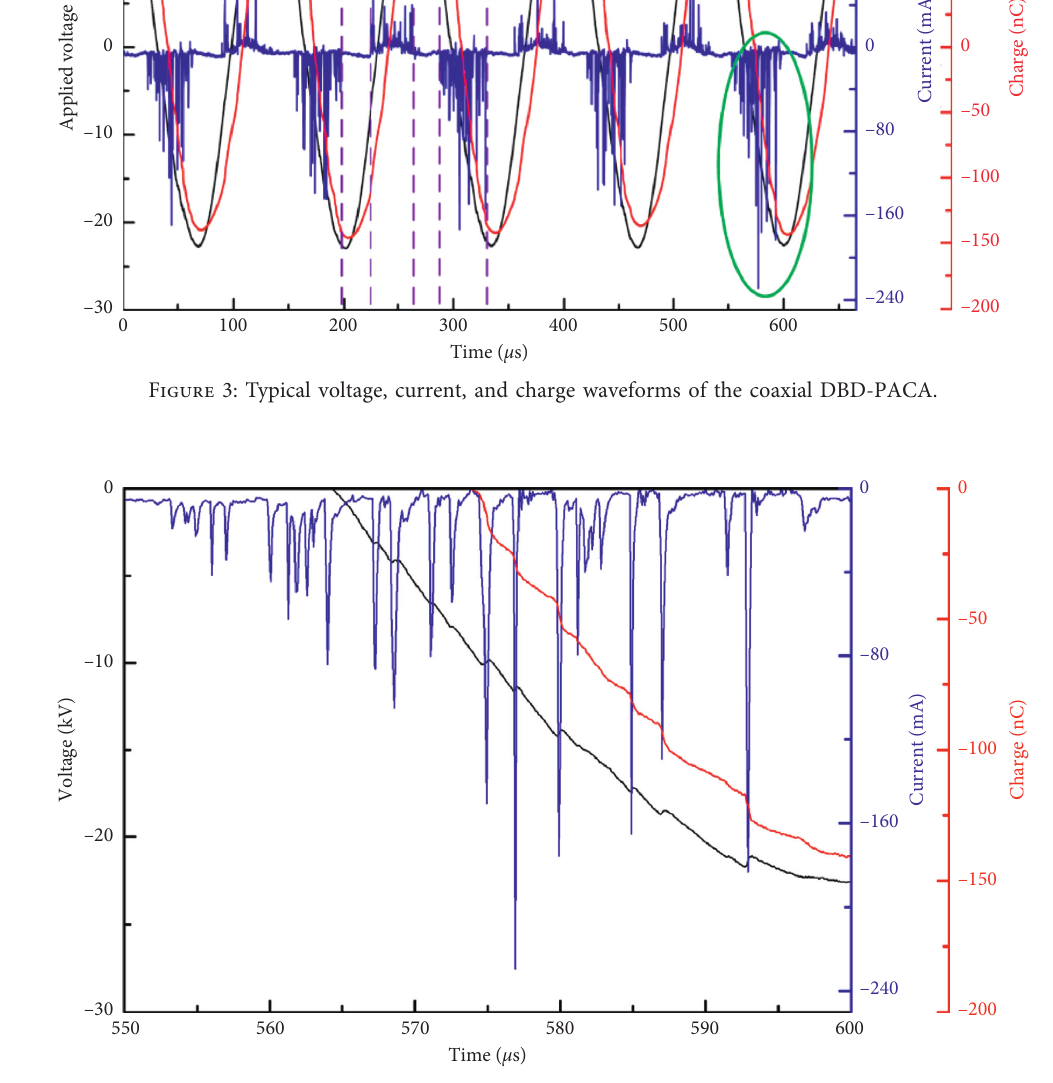
Figure 4: Part of the voltage, current, and charge waveforms of the coaxial DBD-PACA.